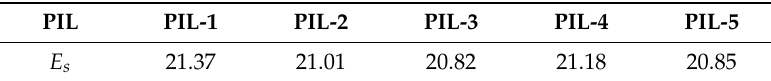
Table 2. E s of PILs in water.